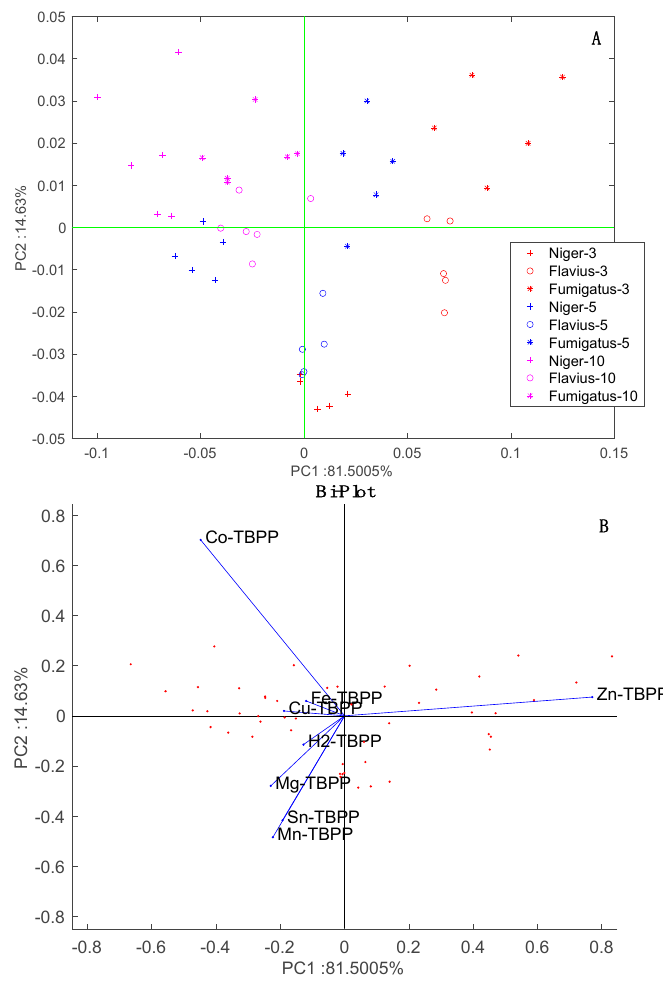
Figure 8. PCA of Aspergillus headspace data. ( A ) scores plot, ( B ) bi-plot where the loadings of sensors are indicated. In Figure 8A, Aspergillus species are marked with the same symbol whose colors identifies the time after incubation.